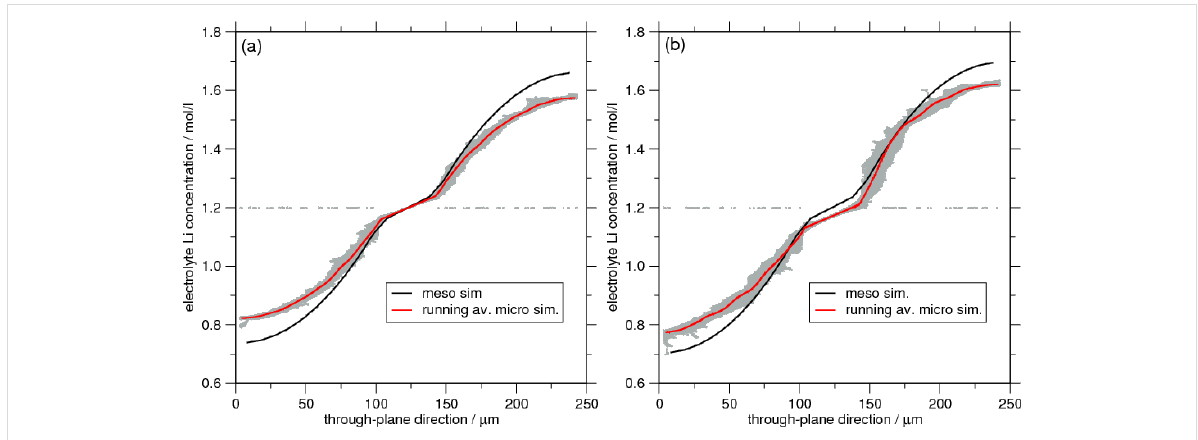
Figure 3: Distribution of electrolyte concentration in dependence of position in through-plane direction at a capacity ratio of 0.42 for (a) spherical parti- cles and (b) prolate spheroids. Each panel compares results of the micro-simulation with a corresponding meso-scale simulation.